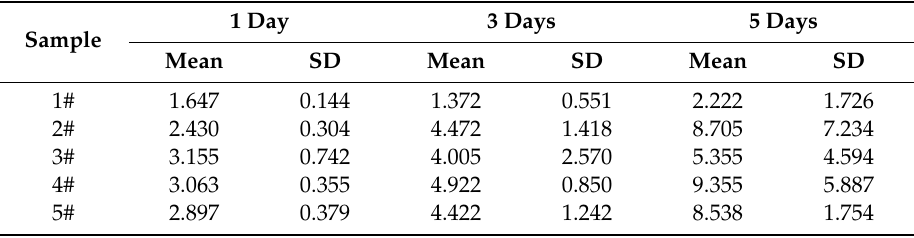
Figure 10. Viability results of MC3T3-E1 cells cultured in MAO-WE43 and GelMA / MAO-WE43 samples for 1, 3, 5 days. Table 4. The number of MC3T3-E1 cells cultured in MAO-WE43 and GelMA / MAO-WE43 samples for 1, 3, 5 days (10 4 cells/mL).